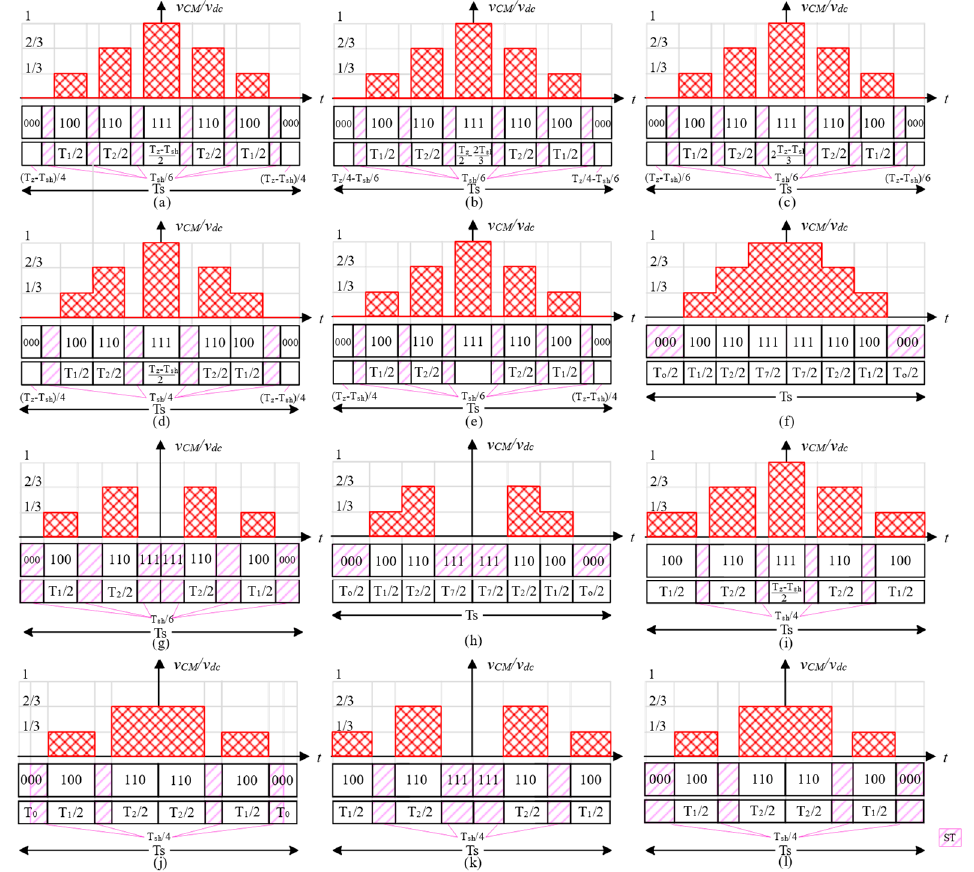
Figure 10. CMV waveforms in a sample time. [( a ) 1 Φ /SVM6, ( b ) 1 Φ /SVM4(a), ( c ) 1 Φ /SVM4(b), ( d ) 3 Φ /SVM2 at random k], ( e ) 1 Φ /SB/SPWM, ( f ) 1 Φ /SB/MSVM, ( g ) 1 Φ /MB/THM, ( h ) 1 Φ /MB/MSVM, ( i ) 1 Φ /SB/+DCCM, ( j ) 1 Φ /SB/-DCCM, ( k ) 1 Φ /MB/+DCCM, and ( l ) 1 Φ /MB/-DCCM. Table 2. Common-mode Voltages for QZSI.